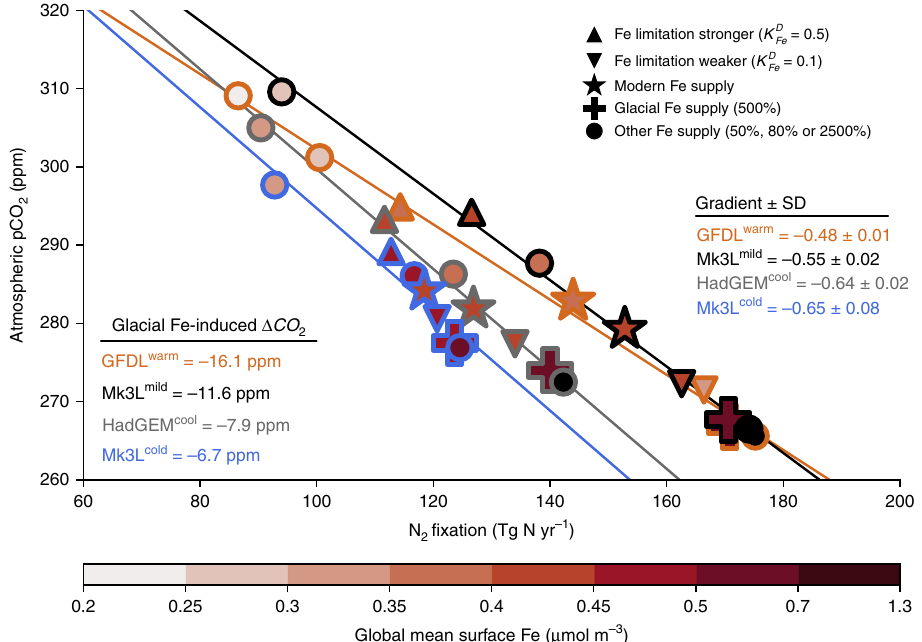
Fig. 2 N 2 fi xation and its relationship with atmospheric CO 2 . The atmospheric reservoir of CO 2 was made responsive to oceanic uptake and release of C by the ocean (see methods). Coloured edges of markers correspond to ocean states as described in the fi gure legend. Star markers represent oceans with carbon cycles equilibrated to the modern Fe deposition 36 under atmospheric CO 2 of − 280 ppm. The plus symbol in each ocean state represents the change due to a glacial increase in Fe supply 6 , which represents a global integrated increase of 500% over the modern supply but is regionally variable (Supplementary Fig. 2). Triangles represent changes in the half-saturation constant for Fe limitation of N 2 fi xers, emulating changes in Fe supply to only N 2 fi xers. Note the diminishing gains in CO 2 drawdown between 500 and 2500% iron deposition scenarios, consistent with Fe-saturation and PO 4 limitation. Regression lines and their slopes (gradient ± standard deviation (SD)) represent the linear relationship between N 2 fi xation and atmospheric CO 2 , with a multi-ocean mean of 0.58 ± 0.03 ppm CO 2 sequestered for every additional Tg N yr − 1 . Source data are provided in the source data fi